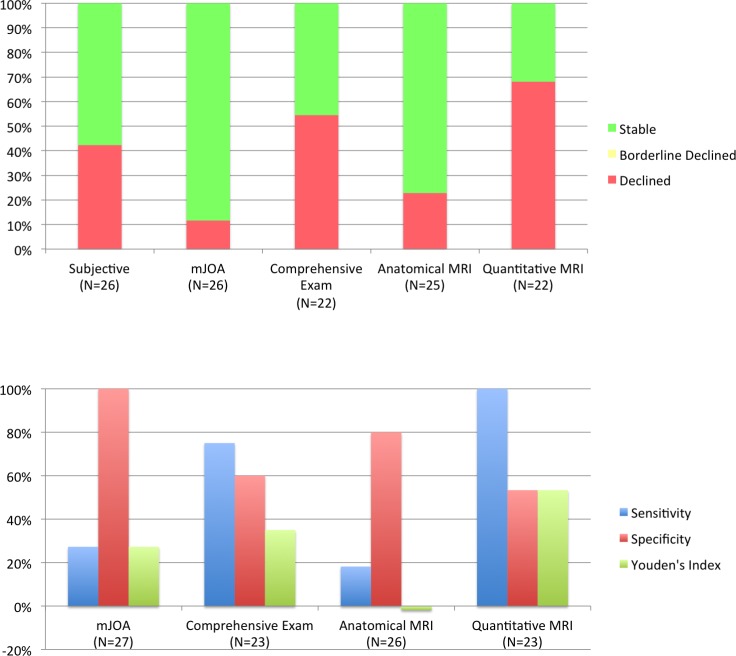
Comparison of methods to monitor for myelopathic progression in DCM.Top panel: The bar graph displays the fraction of subjects that are deemed to be stable (green), borderline declined (yellow), or declined (red) for each clinical and MRI method of monitoring. For mJOA, a 1-point decrease is considered borderline and ≥ 2-point decreases are considered declined. For comprehensive examinations, subjects that have 1 or 2 measures that worsen ≥ 5% are considered borderline and worsening of ≥ 3 measures is considered declined. For anatomical MRI, any new or increased compression that can be visually appreciated is considered declined. For qMRI, deterioration of ≥ 1 measure is considered declined. DCM: degenerative cervical myelopathy; mJOA: modified Japanese Orthopedic Association. Bottom panel: Diagnostic accuracy of each measure was measured as sensitivity, specificity, and Youden’s Index relative to patients’ subjective impression, which was selected as the clinical case definition.